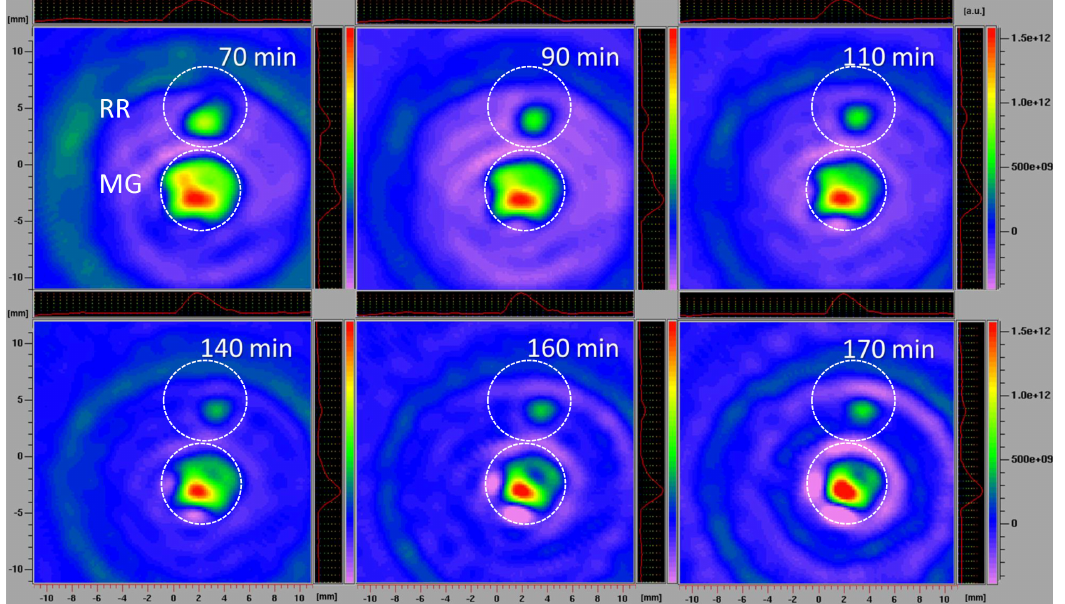
Figure 7. L − band 2D EPR images of MG and RR bittersweet fruits recorded after 70, 90, 110, 140, 160, and 170 min. The upper signal relates to the RR and the lower to the MG fruits. The signal amplitude in arbitrary units is shown on color scales, which present the intensities/concentrations of the 3CP spin probe in samples, with red color indicating the zones/tissues with the highest content of 3CP in the form of nitroxyl radical. The light/dark green colors indicate tissues with lower levels of 3CP in the form of nitroxyl radical.